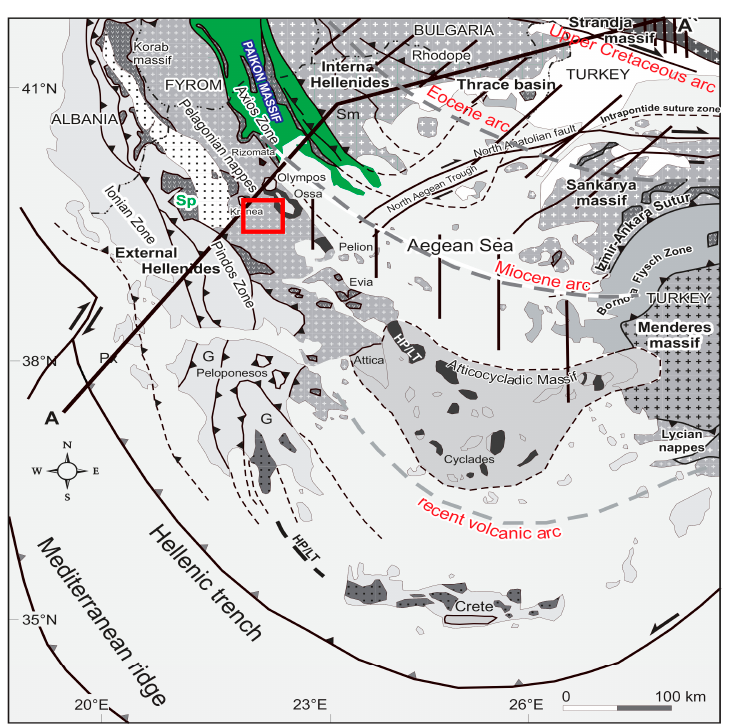
Figure 2. Geological map of the Hellenides with the main structural domains and their continuation to the adjacent orogenic belts [28]. The proposed cross-section of Figure 3 and the study area (red rectangular) are also shown [33].